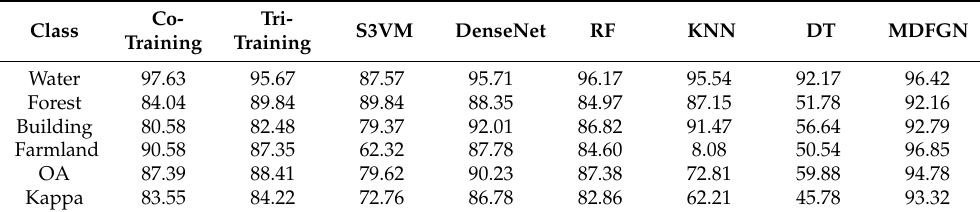
Table 2. Classification accuracy (%) for Rs2-Flevoland